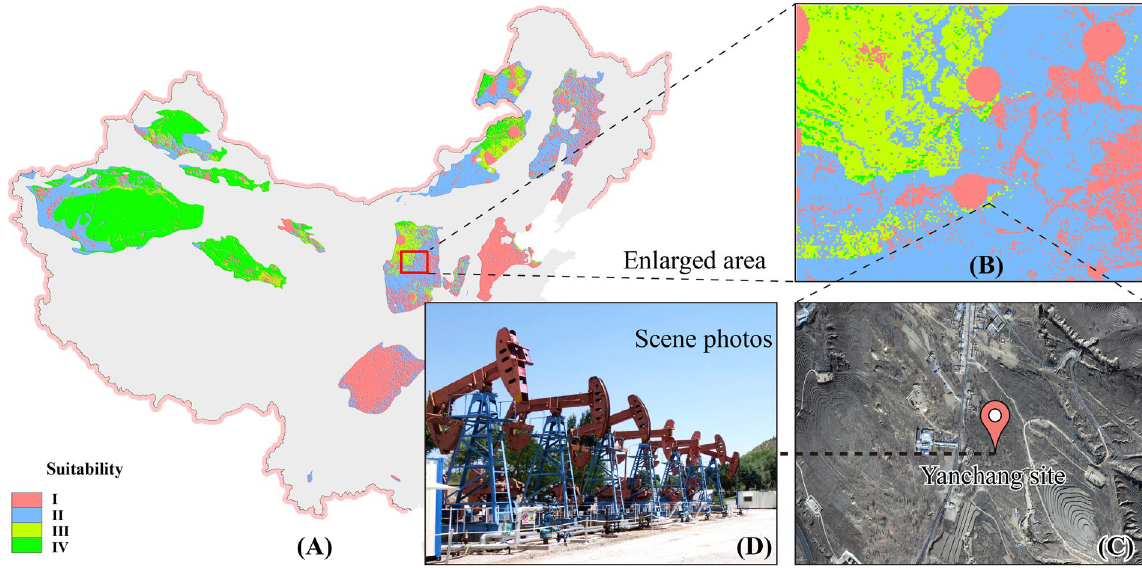
Figure 10. Environmental suitability of the Yanchang CO 2 Capture, Utilization and Storage project. Four categories of suitability for CO 2 storage include I and II, III and IV with increasing suitability. ( A ) Environmental suitability results of China; ( B ): Enlarged area in ( A ) of Yanchang site; ( C ): Remote sensing images of Yanchang site; ( D ): Scene photo of Yanchang site. The map in this figure were generated by software ArcGIS 9.2 (http://www.esri.com/arcgis/about-arcgis) based on our own data. The China spatial boundary GIS data is from the National Geomatics Center of China (affiliated with National Administration of Surveying, Mapping and Geoinformation of China), which provides the basic GIS data for China. The satellite map in Fig. 10C was obtained from a commercial source image bought under a contract from the Institute of Remote Sensing and Digital Earth, Chinese Academy of